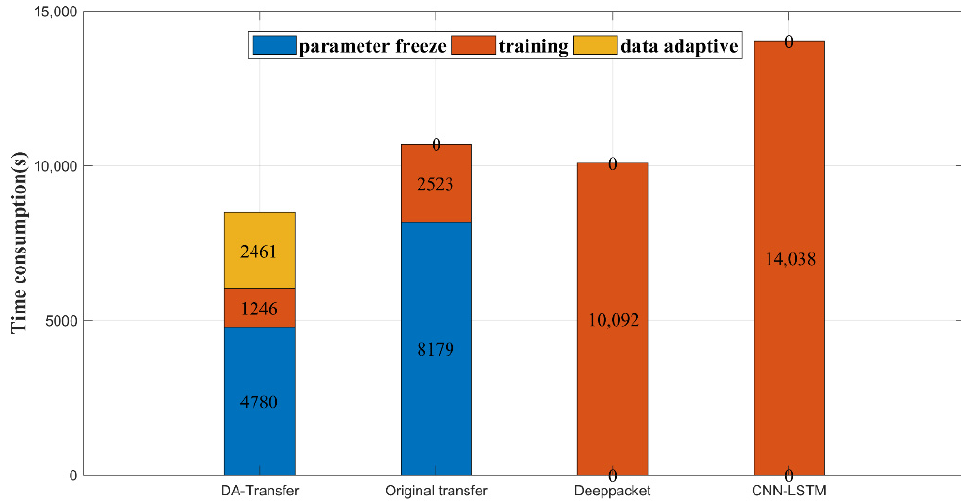
Figure 10. Time consumption of four classification methods.